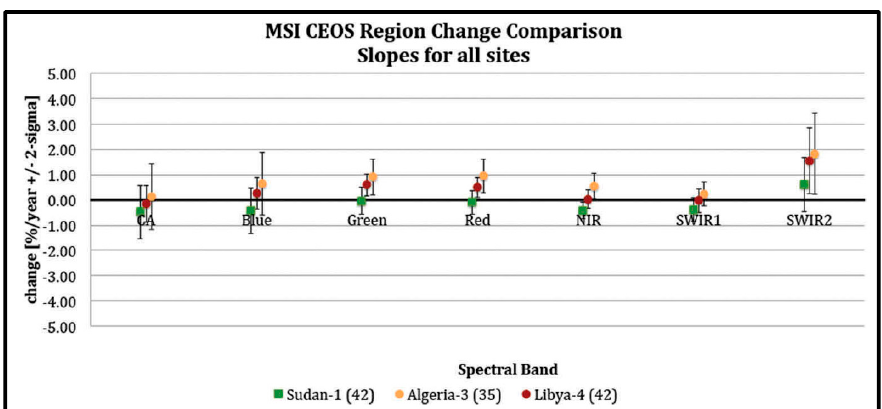
Figure 7. The lifetime trend of 7 Sentinel-2A MSI bands at three PICS [54].